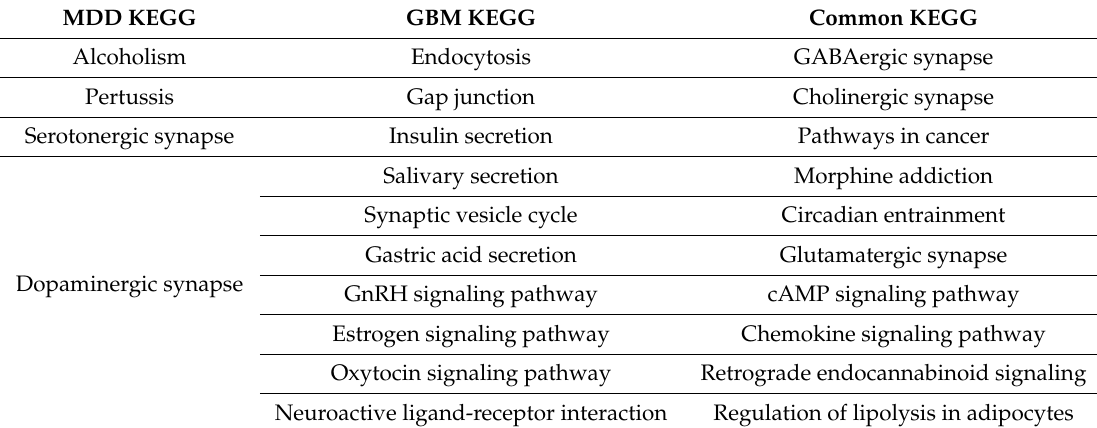
Table 3. Functional enrichment of significant core gene module—KEGG. MDD, Major Depressive Disorder. GBM, glioblastoma. MDD KEGG: the unique KEGG pathways of significant core gene module of Major Depressive Disorder; GBM KEGG: the unique KEGG pathways of significant core gene module of glioblastoma; Common KEGG: the common KEGG pathways of significant core gene module in Major Depressive Disorder and glioblastoma.